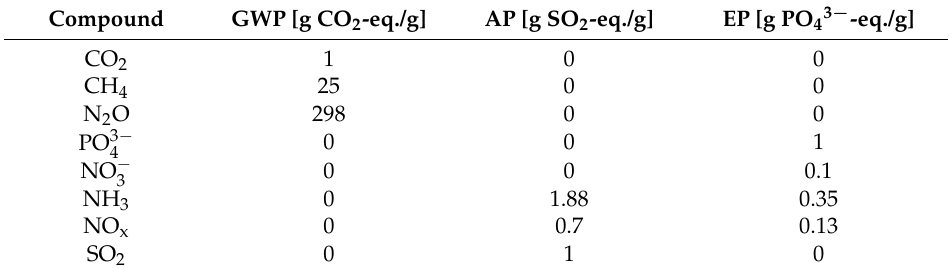
Table 2. Conversion factor for CO 2 equivalents (GWP—global warming potential) [23], SO 2